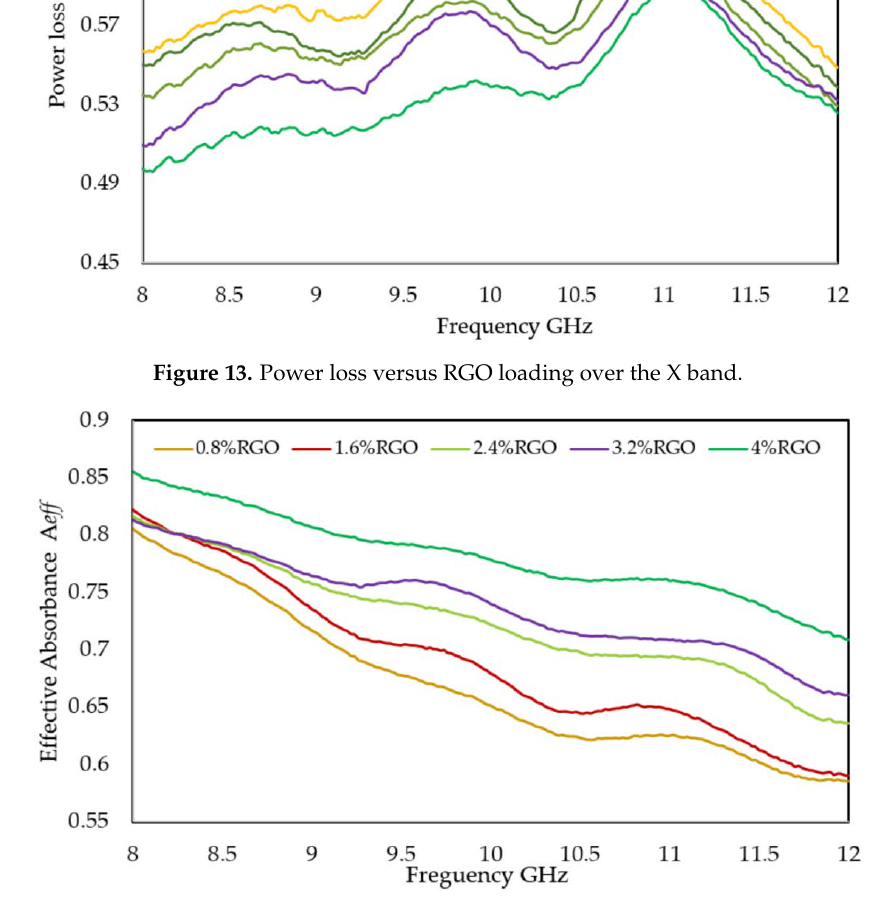
Figure 14. Effective absorption versus RGO loading over the X band.